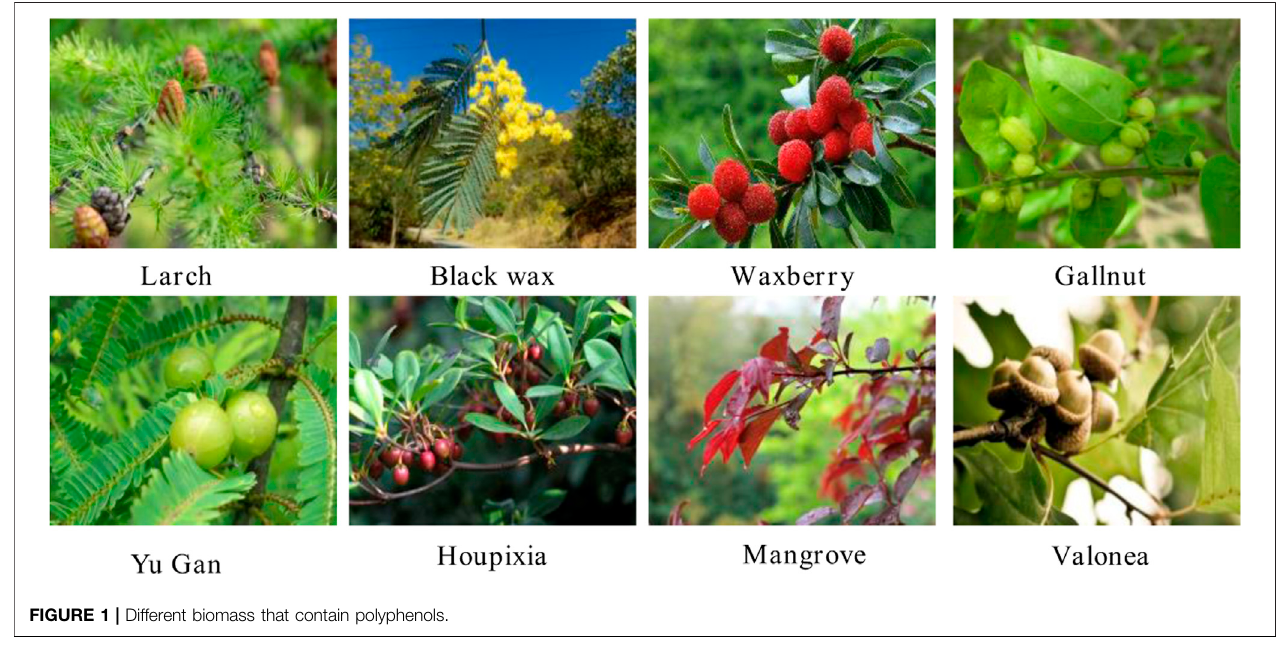
FIGURE 1 | Different biomass that contain